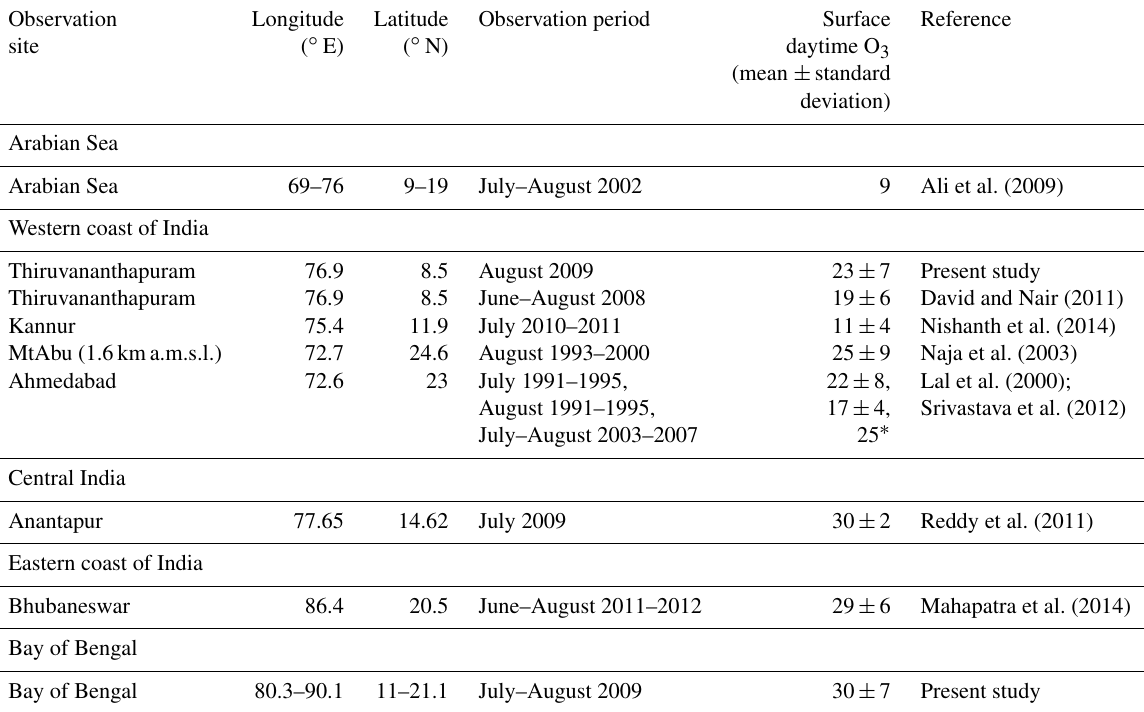
Table 2. A comparison of averaged surface O 3 mixing ratios measured at various sites during summer monsoon period. Observation Longitude Latitude Observation period